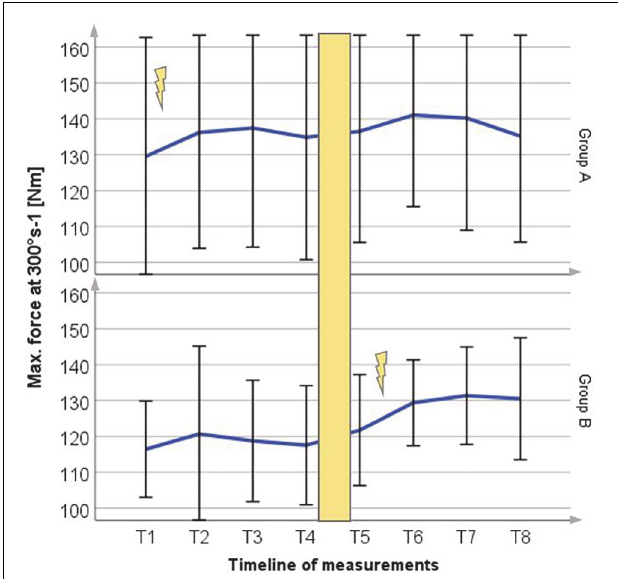
FIGURE 6 | Mean ( ± SD) change in maximum voluntary force at 300 ◦ /s for Group A period 1 and Group B period 2, compared to each control group ( p = 0.02). Lightning bolt represents each respective WB-EMS period; yellow area = wash-out phase.